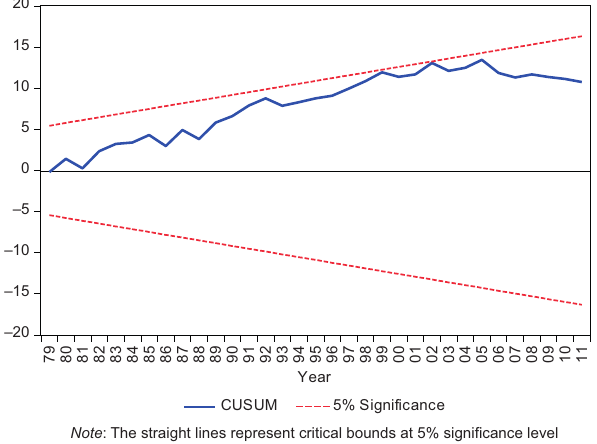
Fig. 1. Plot of cumulative sum of recursive residuals